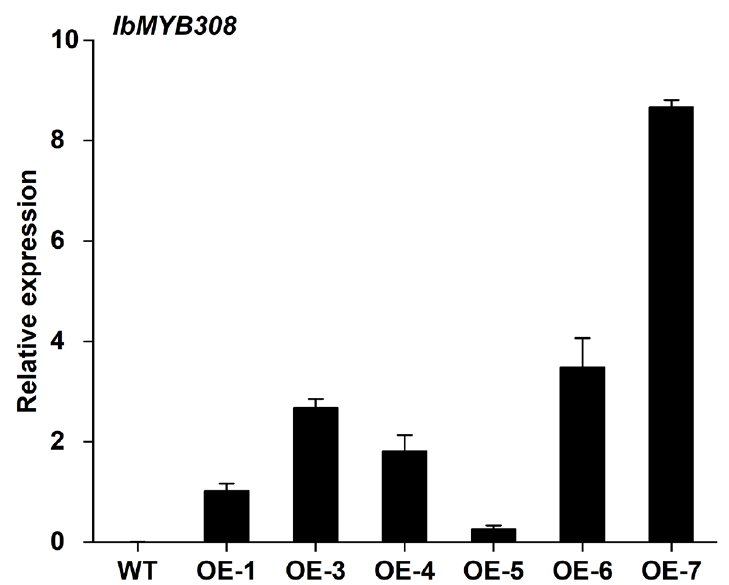
Figure 5. Identification by qRT-PCR of IbMYB308 transcript in the six overexpression tobacco lines and the WT. NtActin was used as the internal reference gene. Bars represent SE from the mean of three technical replicates and three biological replicates. Data are presented as the means of three biological replicates ± SD ( n = 3 ).